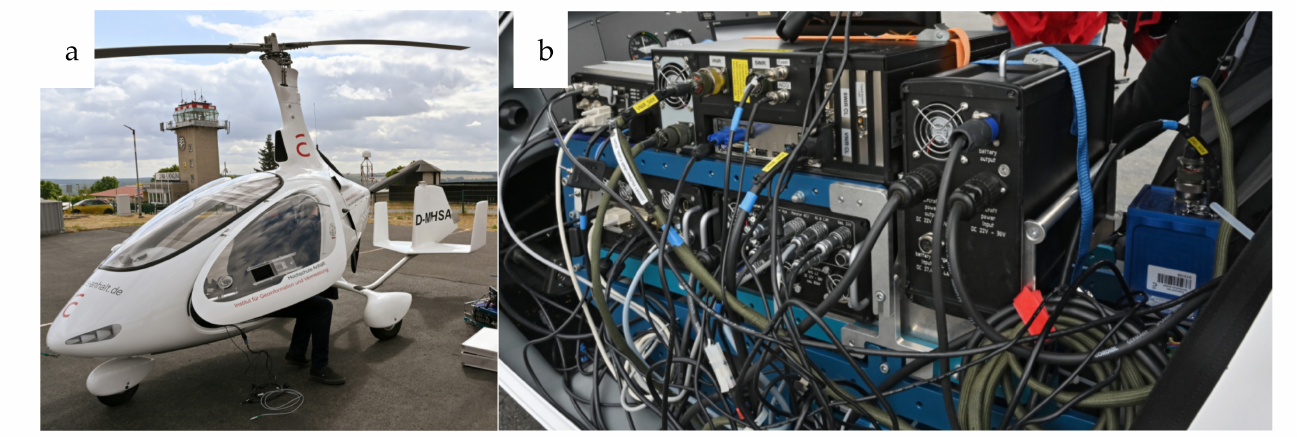
Figure 5. Gyrocopter and mounted camera system ( a ) and the HySpex camera ( b ). Dodgy weather conditions during the flight caused changes between cloudy and sunny periods. This means the weather was mostly sunny with a few scattered clouds, with both study areas being cloud-free at the time of data acquisition. Nevertheless, the spectral data needed a thorough atmospheric correction during